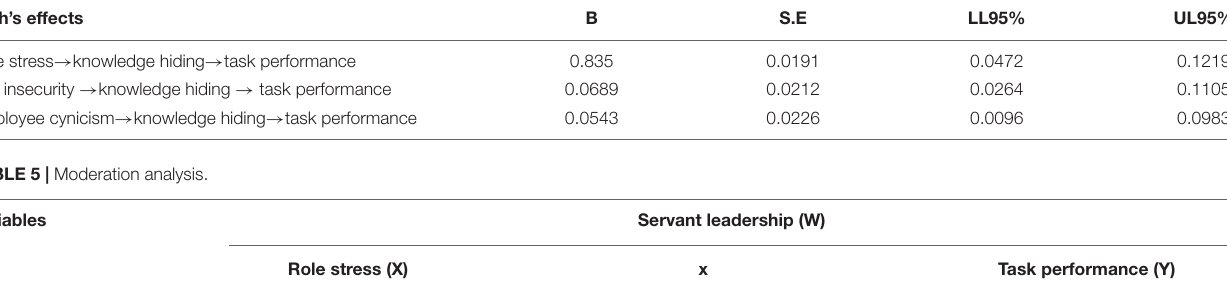
TABLE 4 | Mediation –Bootstraps results.